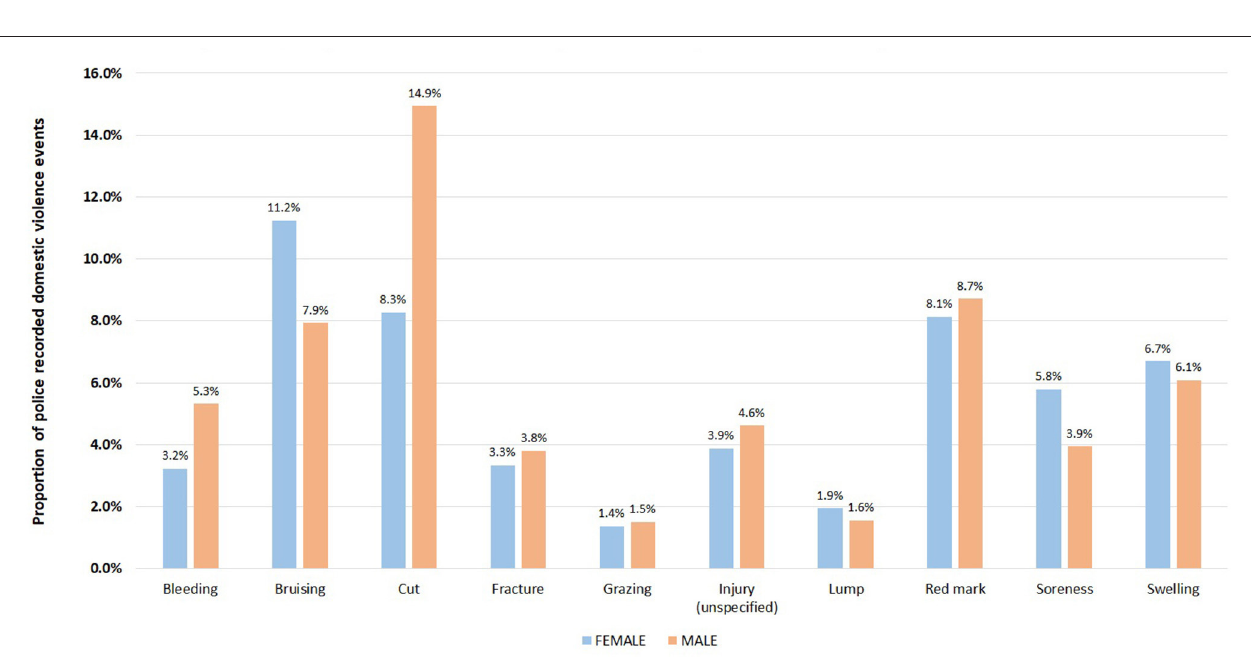
FIGURE 4 | Comparison of proportions of injury types (top 10 only) for male and female victims in 416,441 police recorded domestic violence events in NSW, January 2005–December 2016.